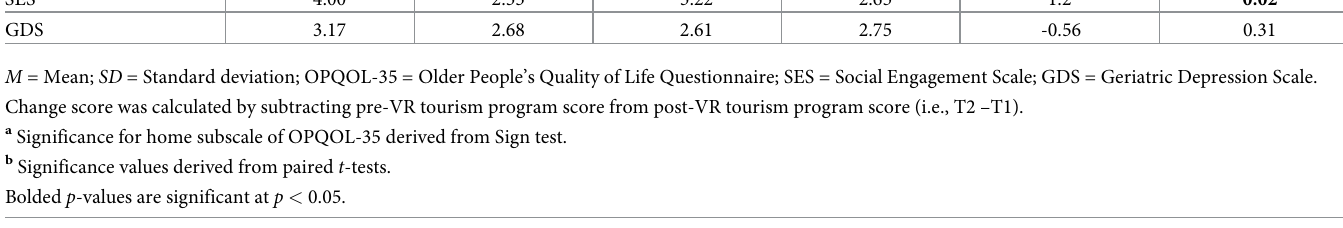
Table 3. Change scores in quality of life, social engagement, and depressive symptoms following the 6-week VR tourism program ( N = 18). Variable Pre-VR program